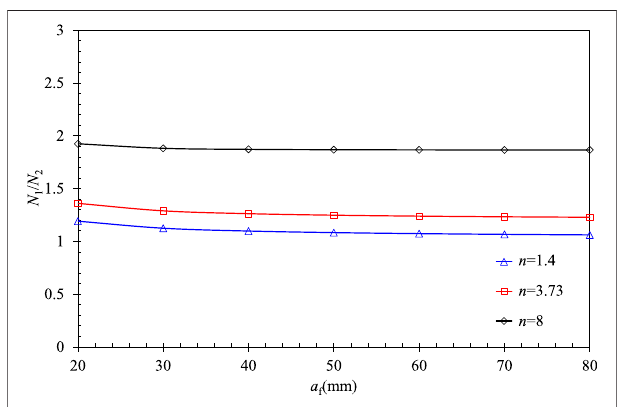
FIGURE 3 | Life ratios for the embedded crack with a 01 (cid:3) 6.5 mm, a 02 (cid:3) 8.0 mm.